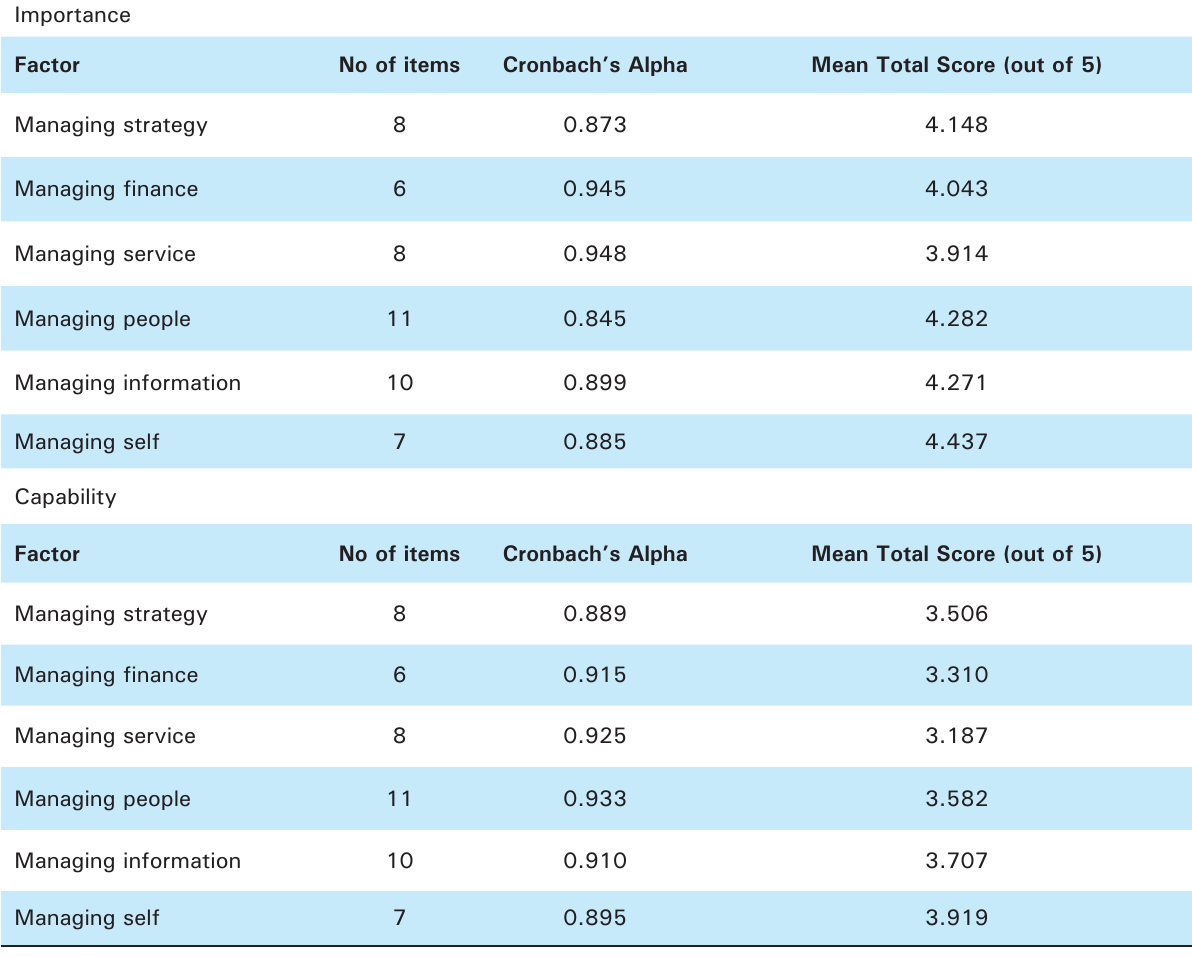
Table 2. Reliability of reported importance and capability scores by factor using Cronbach’s alpha